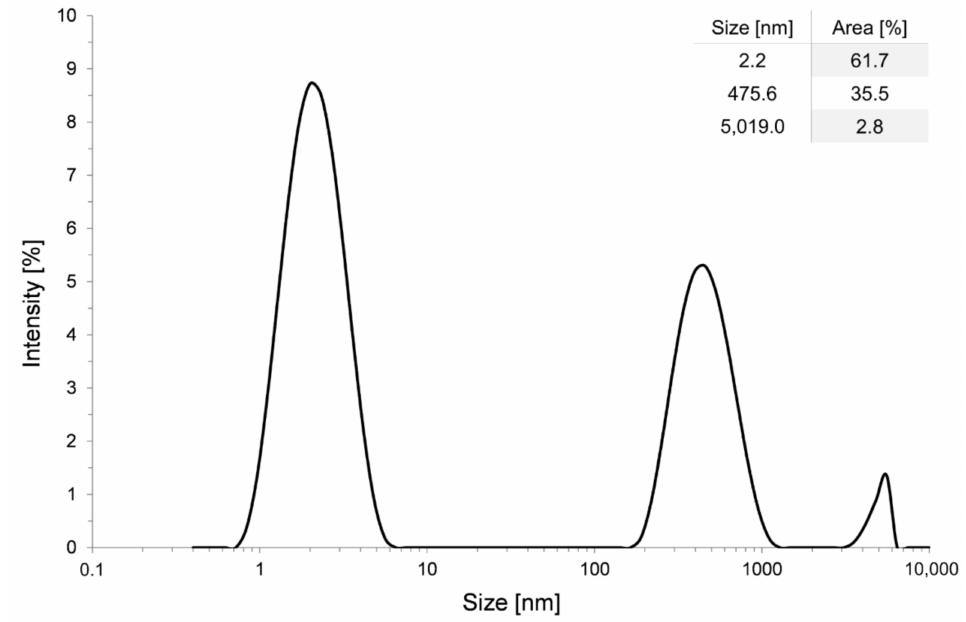
Figure 1. Dynamic light scattering (DLS) spectrum showing the particle size distribution in the alumina sol. Mean size values for each peak and corresponding scattering intensity percentages are reported in the inset